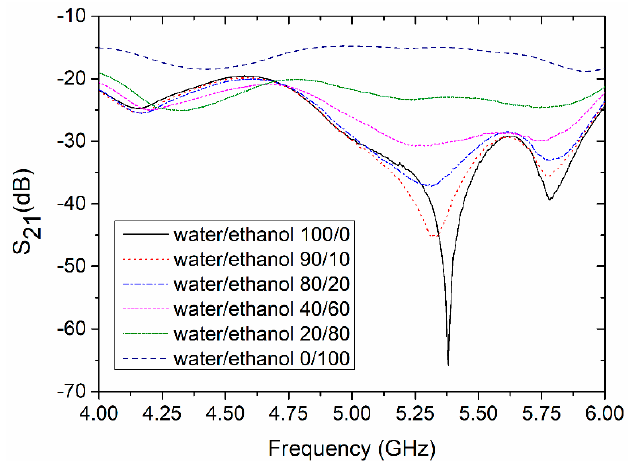
Figure 15. Measured transmission coefficient of the coupler-based sensor (reference channel filled with water).